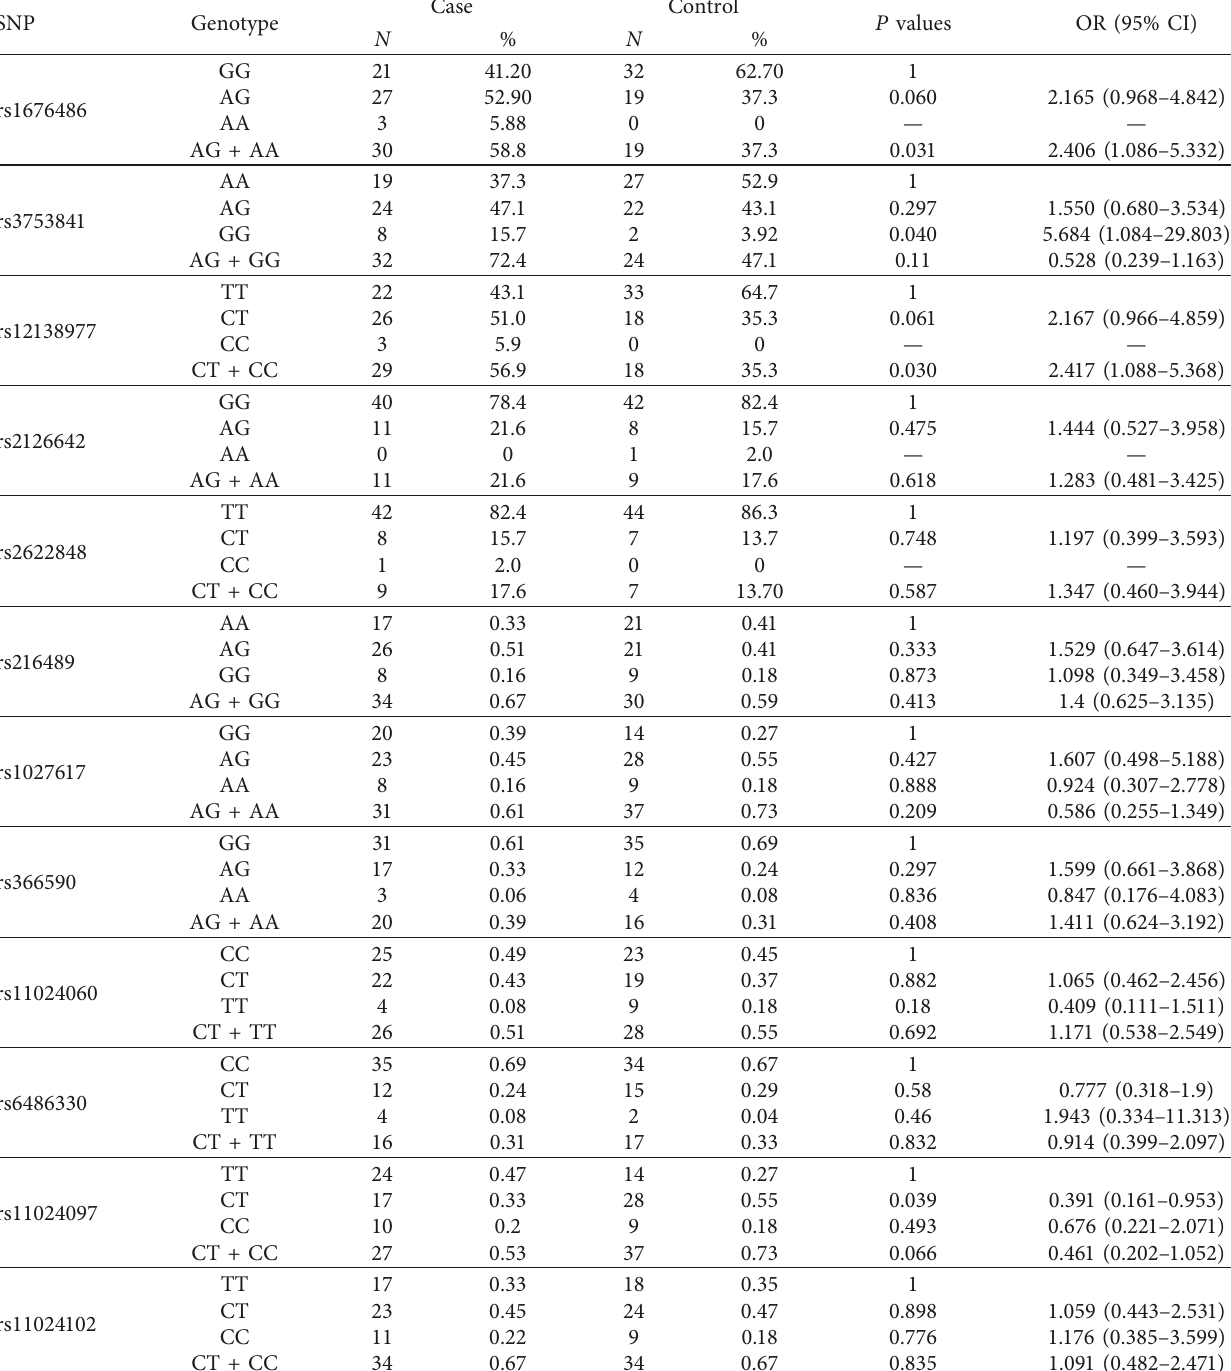
Table 4: Single nucleotide polymorphism genotype frequencies and associations for 12 SNPs between cases and controls. SNP